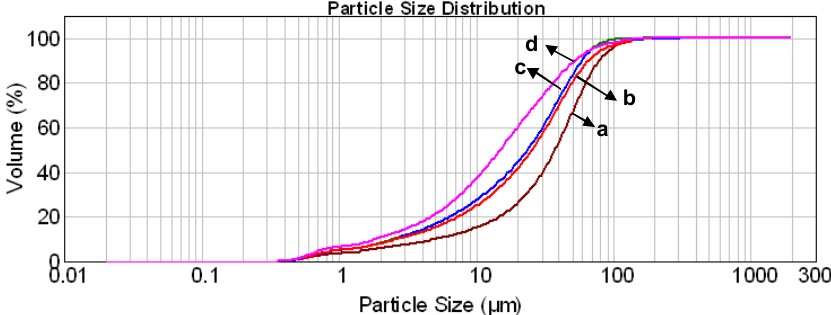
Figure 7. Rosin-Rammler-Sperling diagram of materials grinded for 30 minutes in similar conditions: a- K; b-KZF, c-KZ; d-KF.